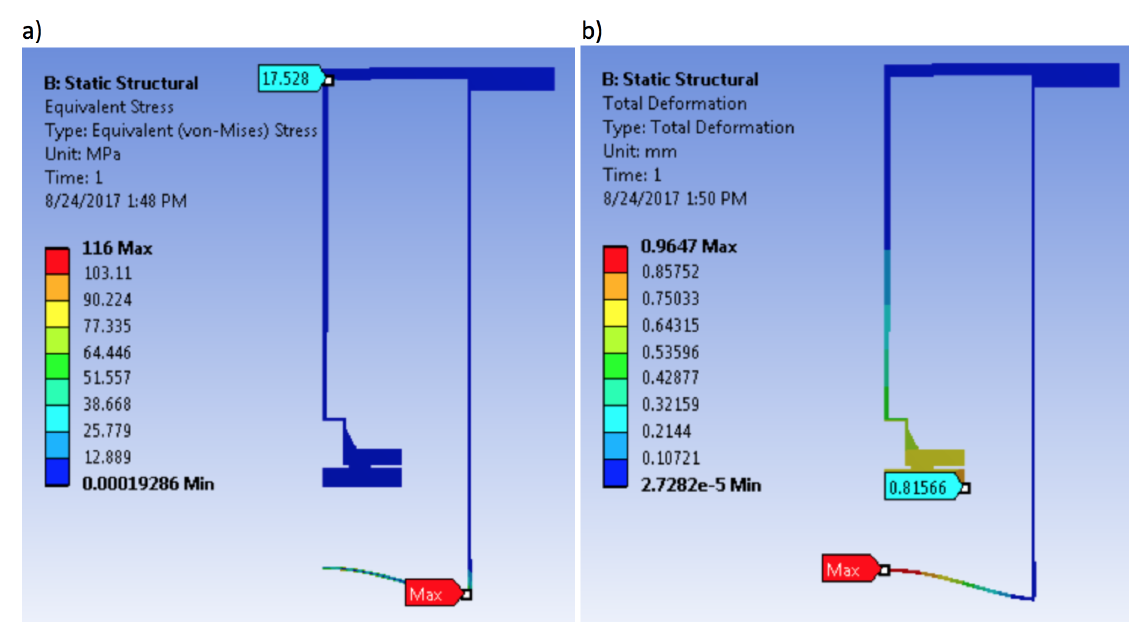
Figure 6: Results of the thermo-structural analysis: a) distribution of the equivalent von Mises stress, b) total